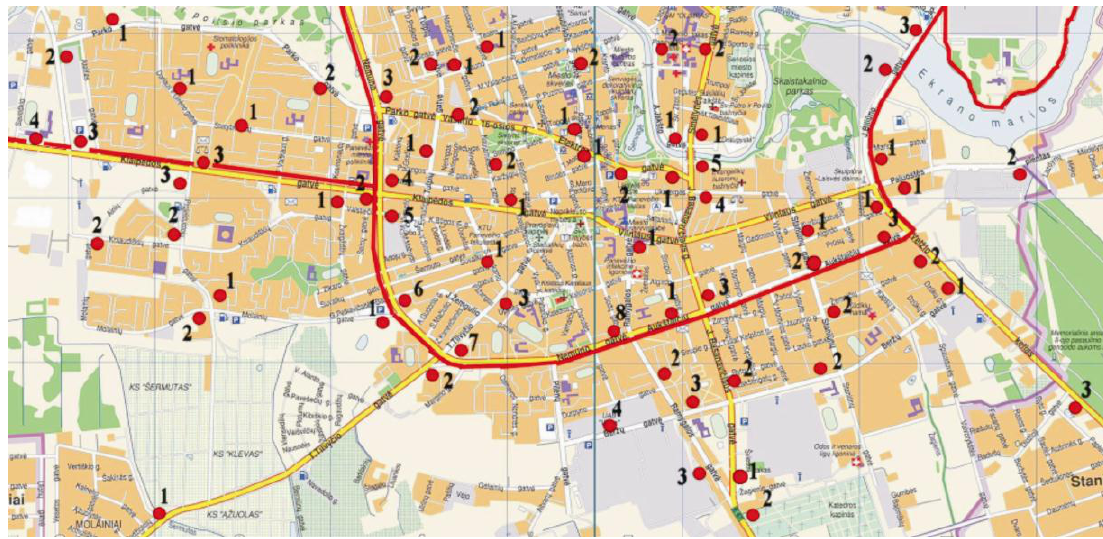
Fig. 1. Measurement location layout in Panevėţys town